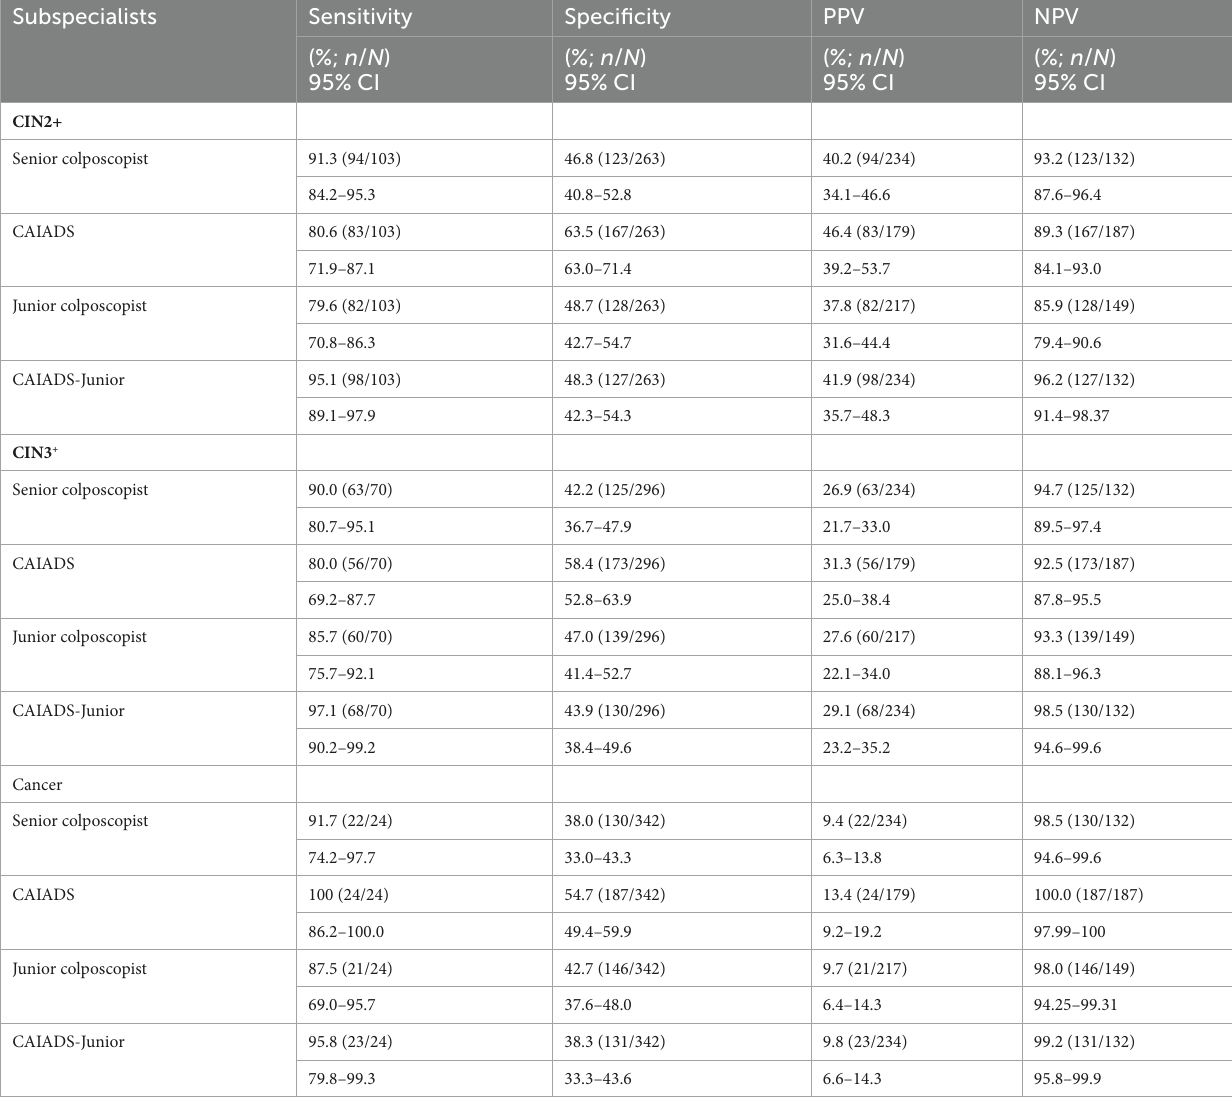
TABLE 3 Diagnostic performance of the subspecialists for different clinical